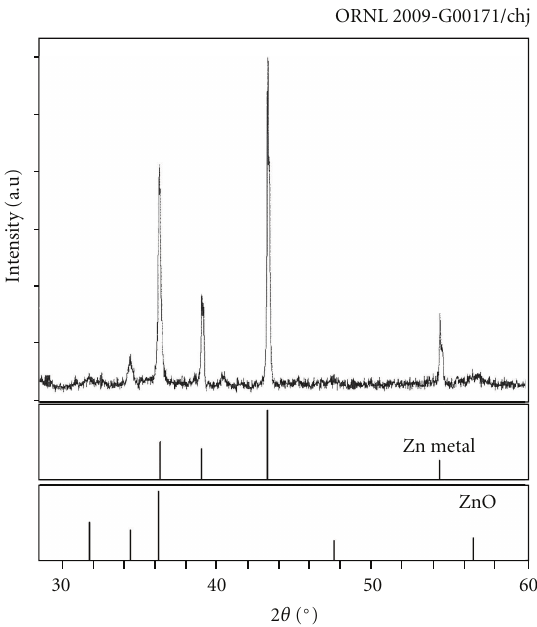
Figure 7: X-Ray di ff raction pattern of the altered surface product generated during the reduction reaction of a ZnO single-crystal PEC cell electrode showing the formation of metallic zinc on the photoanode surface. Weak X-ray di ff raction peaks from ZnO are also present.